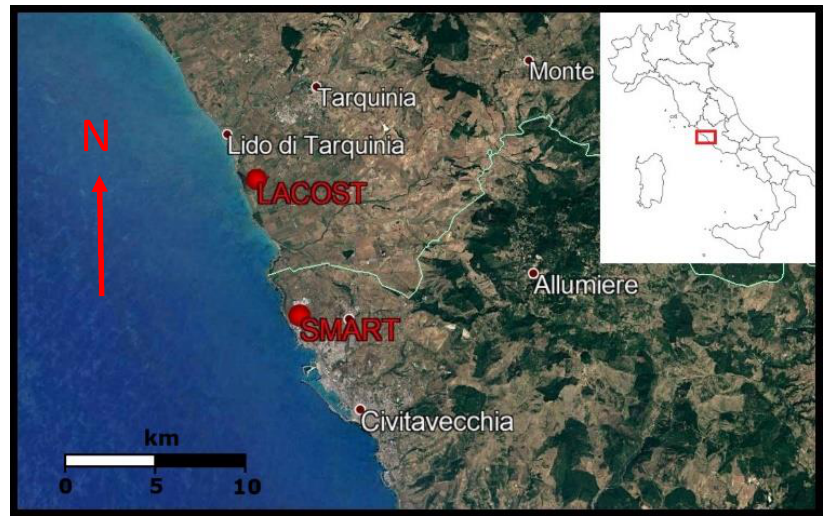
Figure 1. Map of the studied area with the locations of the LACOST and SMART sites.